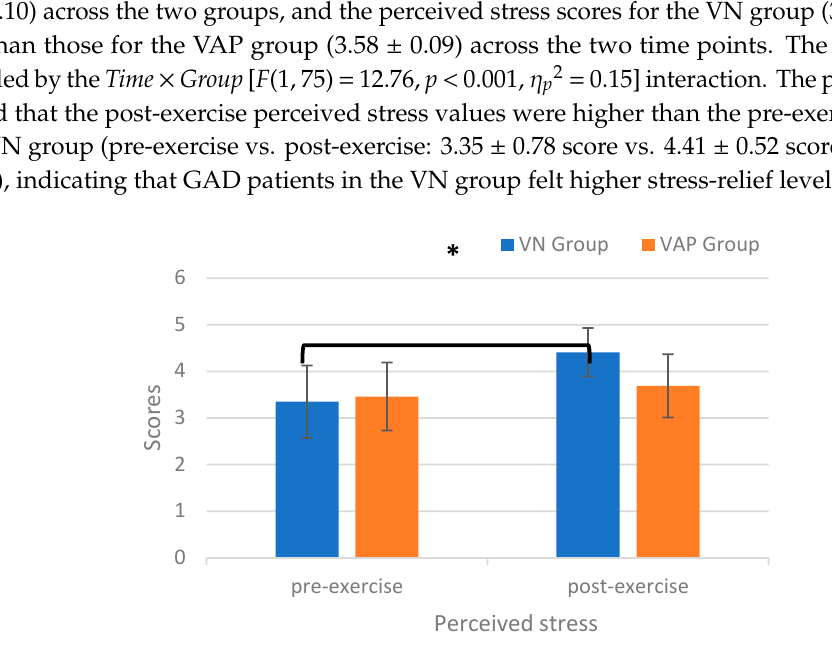
Figure 3. EEG alpha values ( μ V) for the virtual nature (VN) and the virtual abstract painting (VAP) groups before and after the exercise intervention (* p < 0.05).